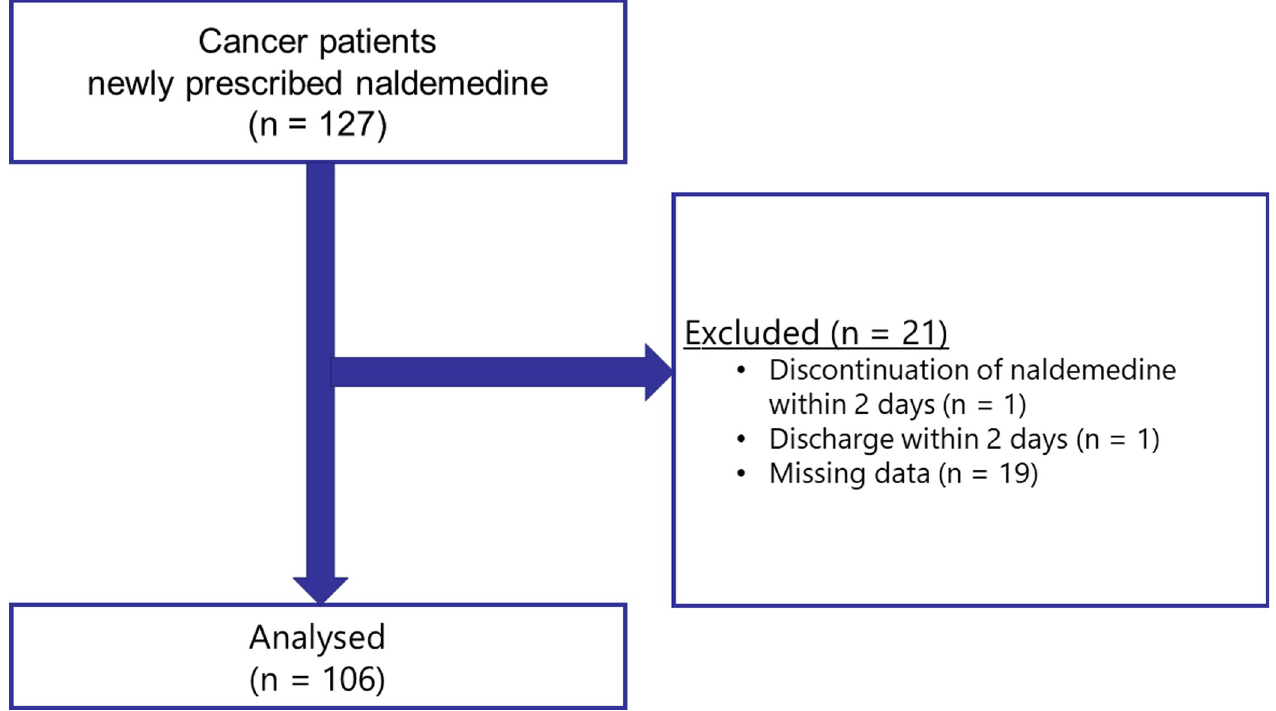
Fig 1. Of the 127 patients extracted, 106 patients were evaluated in this study. A total of 21 patients were excluded from this study due to discontinuation of naldemedine within 2 days (n = 1), discharge within 2 days (n = 1) or missing data (n = 19).